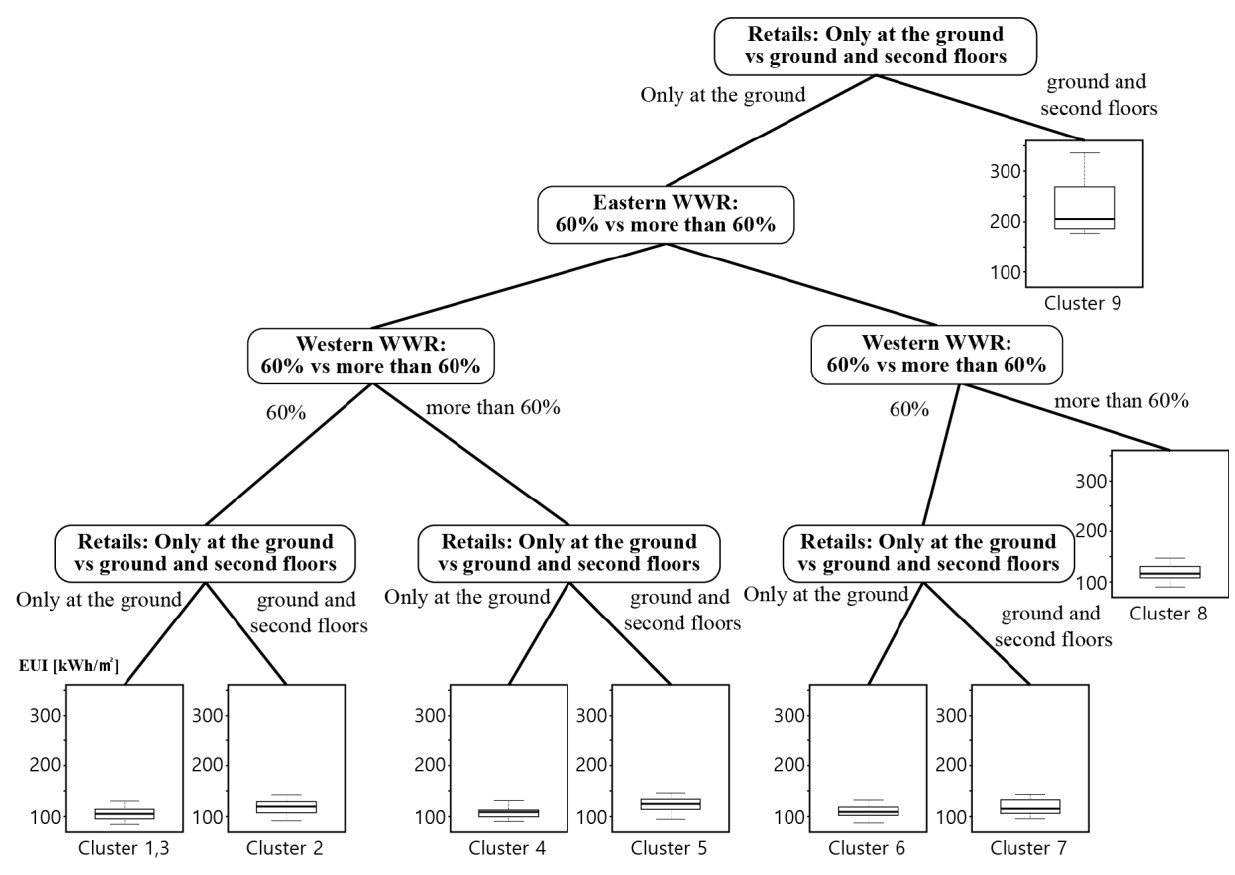
Figure 3. GMM clustering before ( left ) and after ( right ) PCA.